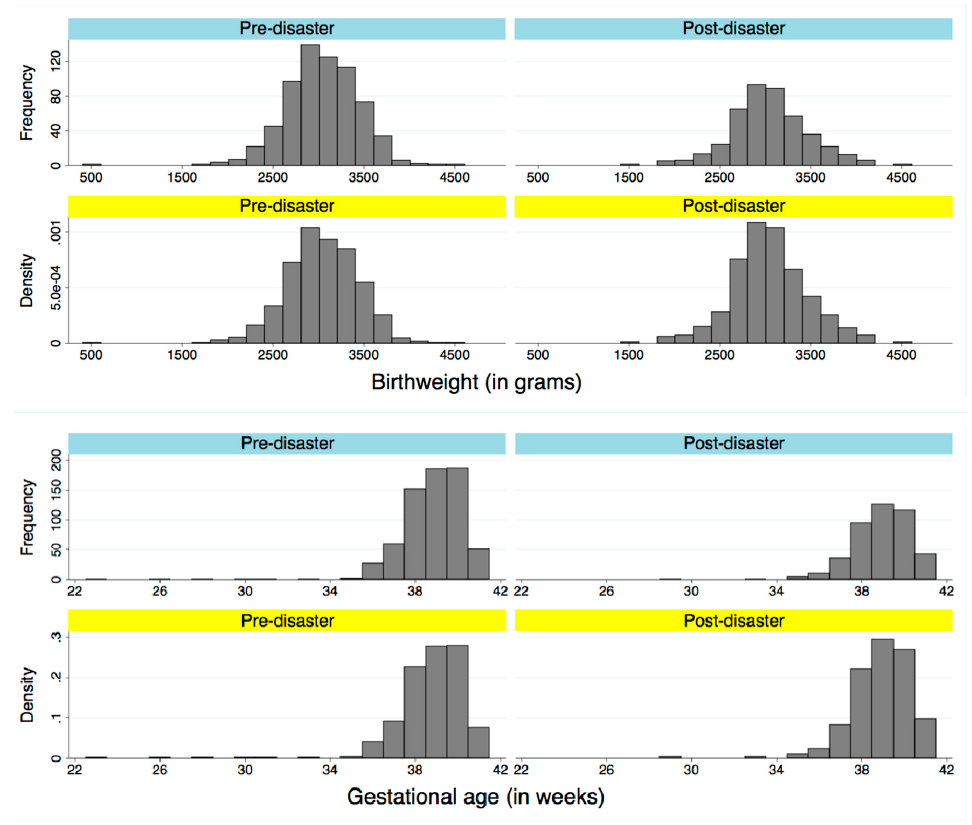
Figure 2. Pre- and post-disaster distribution of birthweight in grams and gestational age at delivery in weeks.